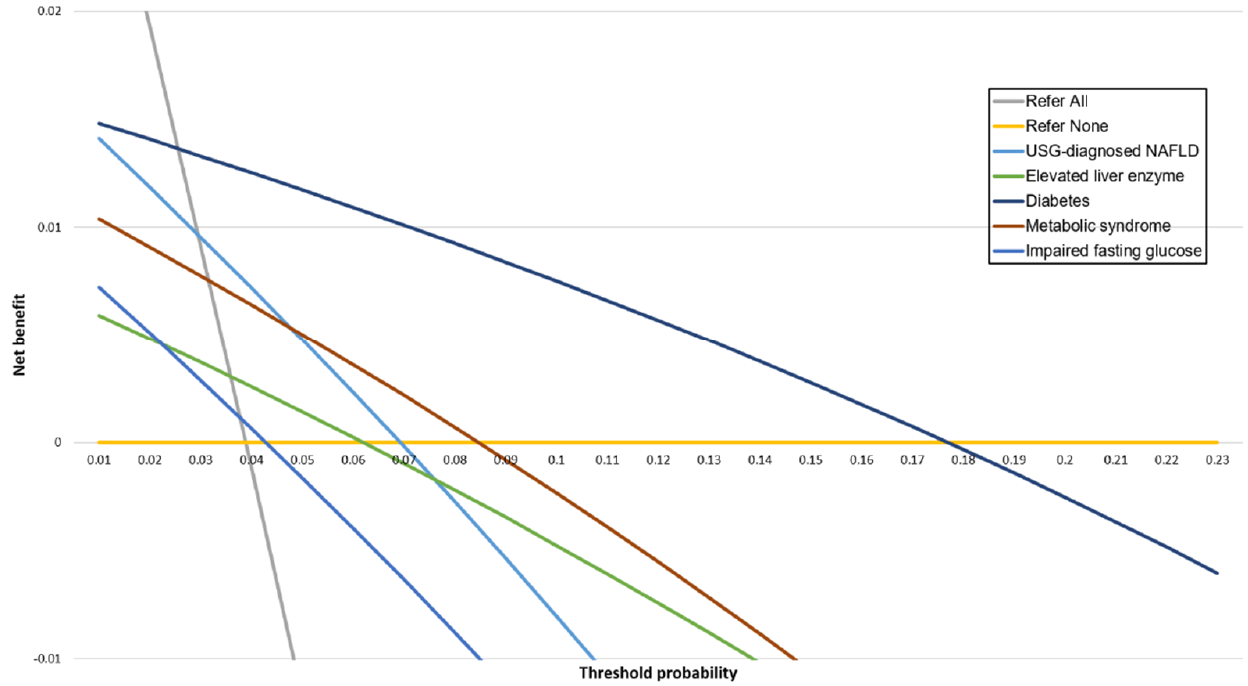
Figure 4. Decision curves for FIB-4 index in five groups.